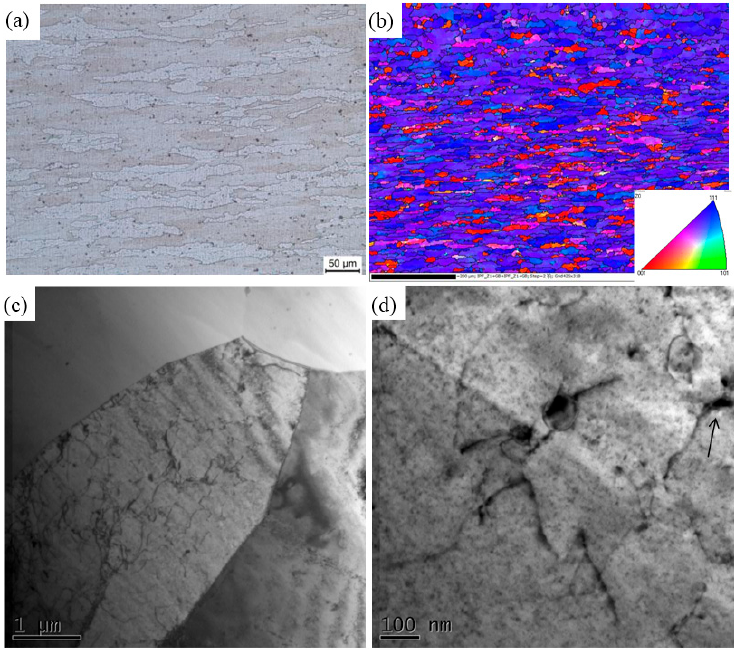
Figure 2. The ( a ) OM; ( b ) OIM; and ( c , d ) TEM micrograph of 7003-T4.